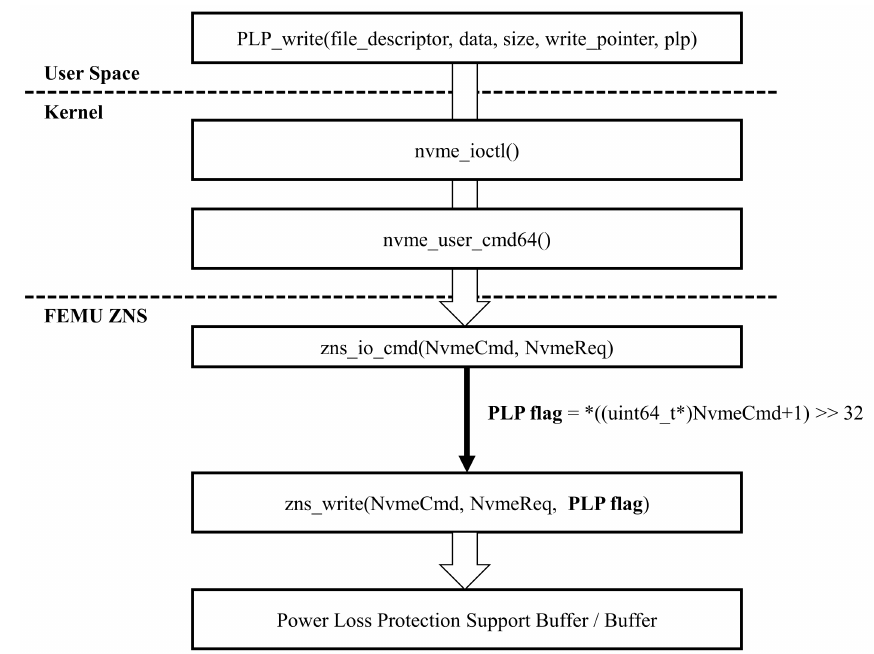
Figure 4. Flowchart of PLP_write() command operation in FEMU